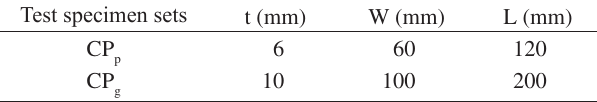
Table 1. Composition formulated for the refractory castable without cement. Raw materials